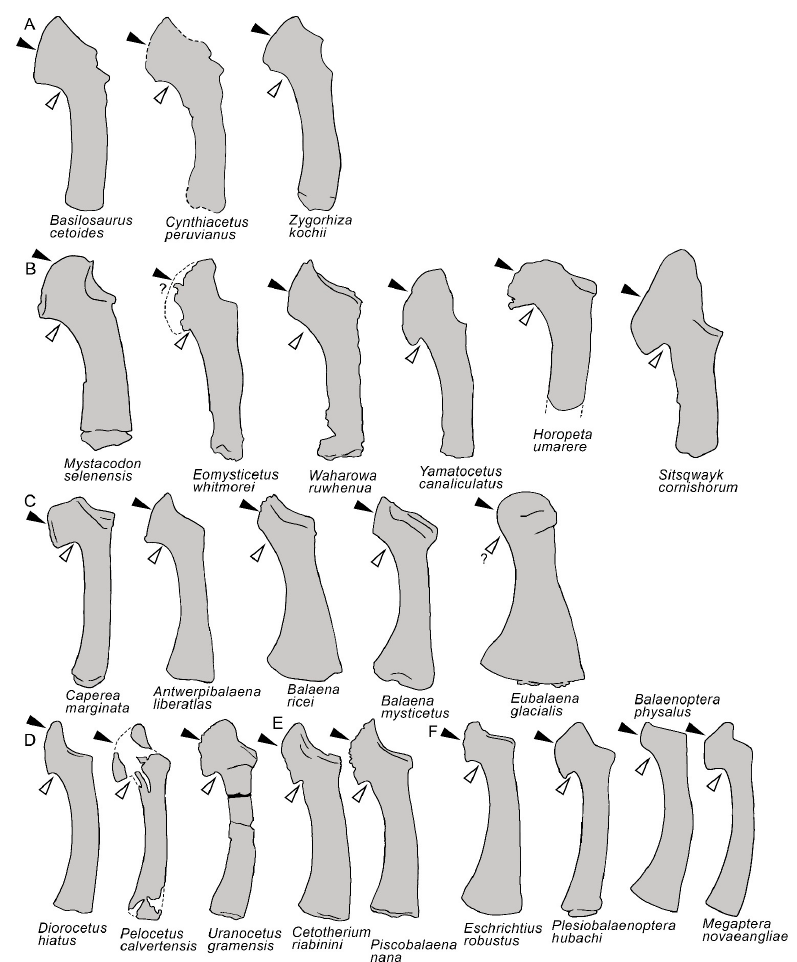
Figure 25. Diversity of the ulna in mysticete and archaeocete cetaceans. The black triangle indicates the olecranon process. The white triangle indicates the shape of the distal border of the olecranon process (continuous curve vs. acute angle). ( A ) Archeocetes. ( B ) Early-diverging, nonbalaenomorph taxa. ( C ) Balaenoidea. ( D ) Thalassotherii. Not to scale. The scapulae are represented as if they shared the same anteroposterior length.